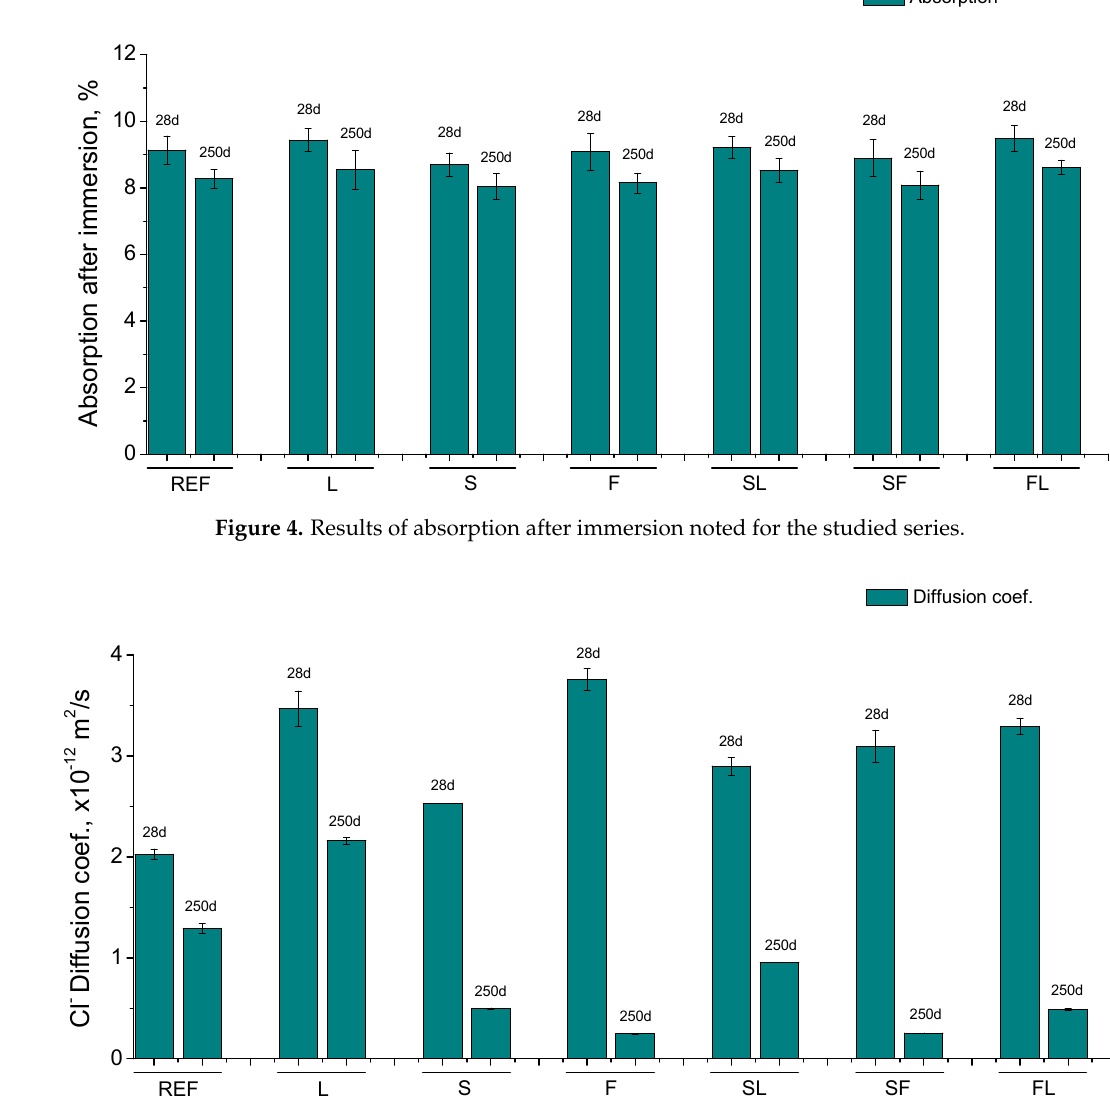
Figure 6. Carbonation front depths observed at 28 and 250 days for the characterized binders.